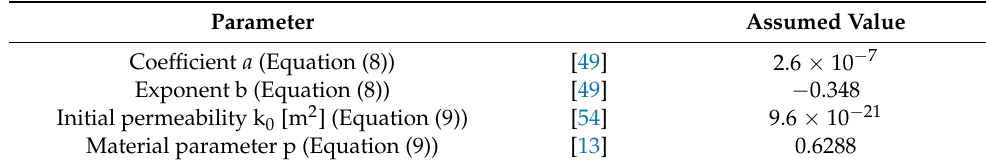
Table 7. Assumed values of parameters used in the calculation of permeability versus effective stress, and coefficients for calculation of threshold pressure in the anhydrite